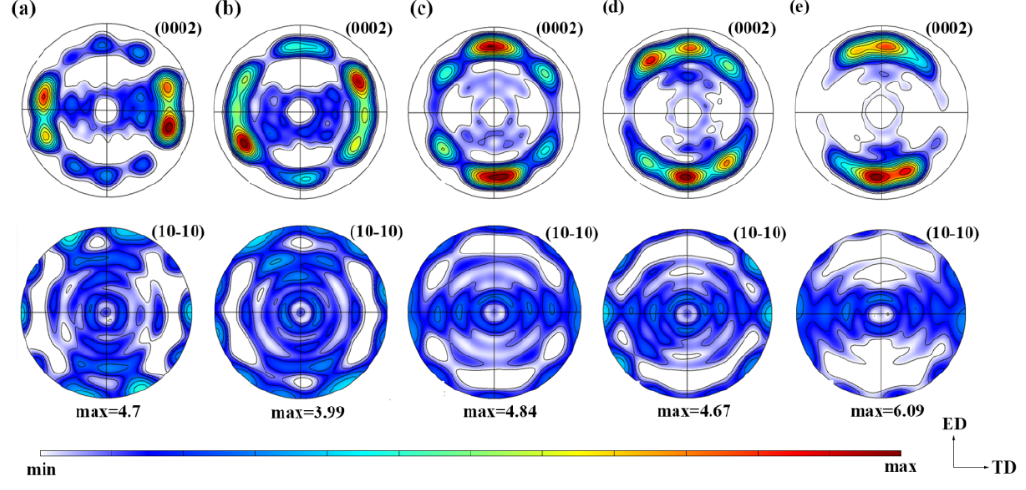
Figure 6. Macro-textures of as-extruded 0.05 wt.% ND/ZK60 composite under different strains at the deformation temperature of 200 °C and strain rate of 1 s −1 : ( a ) 0, ( b ) 10%, ( c ) 20%, ( d ) 30%, and ( e ) 40%.